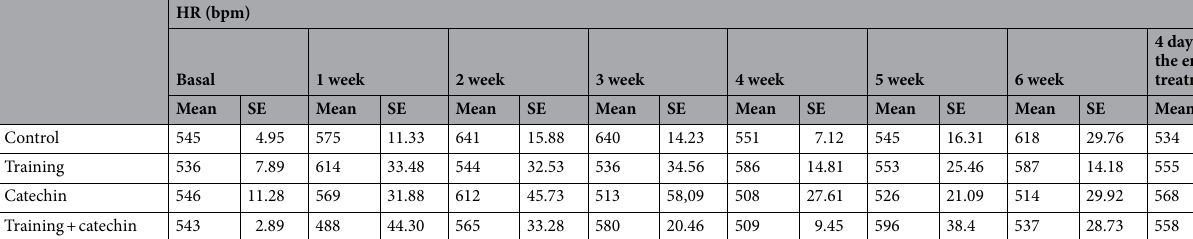
Table 3. Heart rate measured at the arrival in our lab (basal) and at the different times